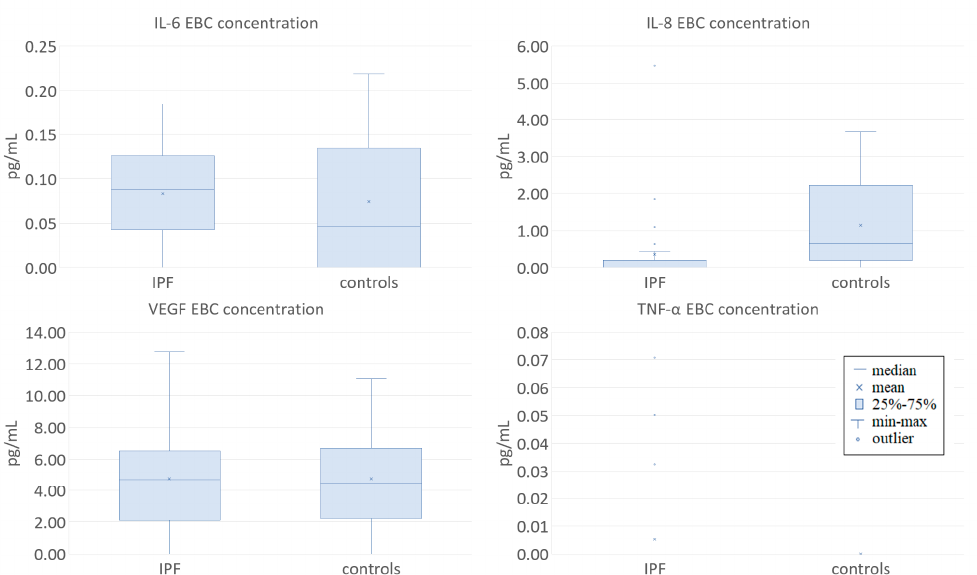
Figure 2. Comparison of the baseline concentrations of selected cytokines in exhaled breath condensate (EBC) from patients with IPF and controls.